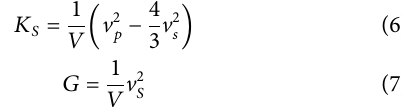
Figure 1 . The unit-cell volumes of β -(Mg